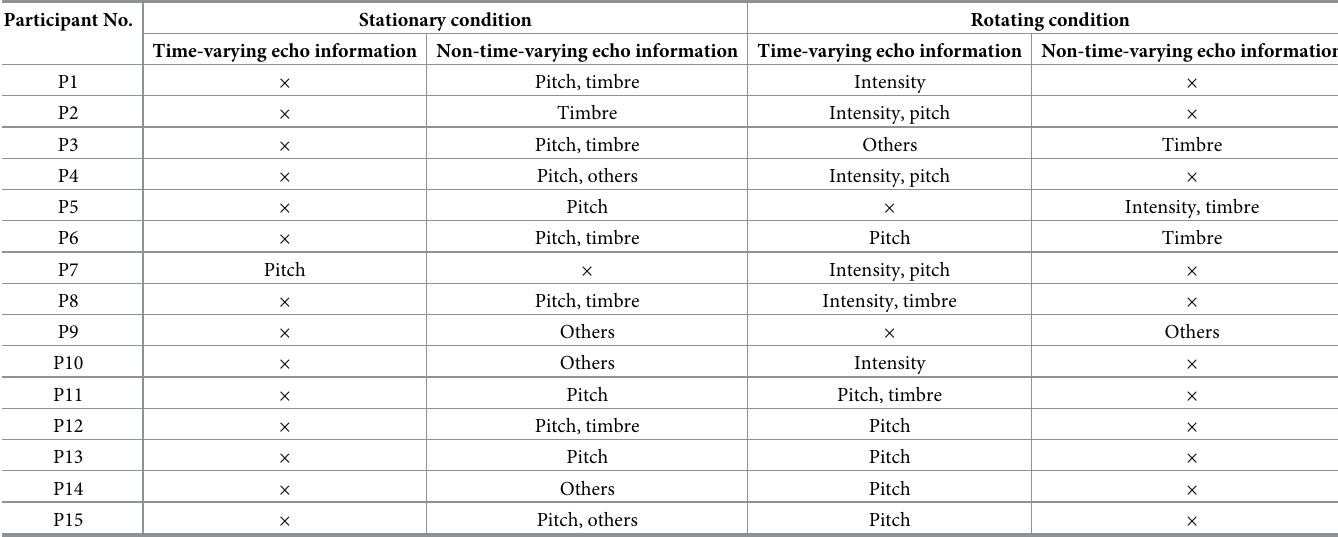
Table 1. Acoustic cues reported by the participants. Participant No.